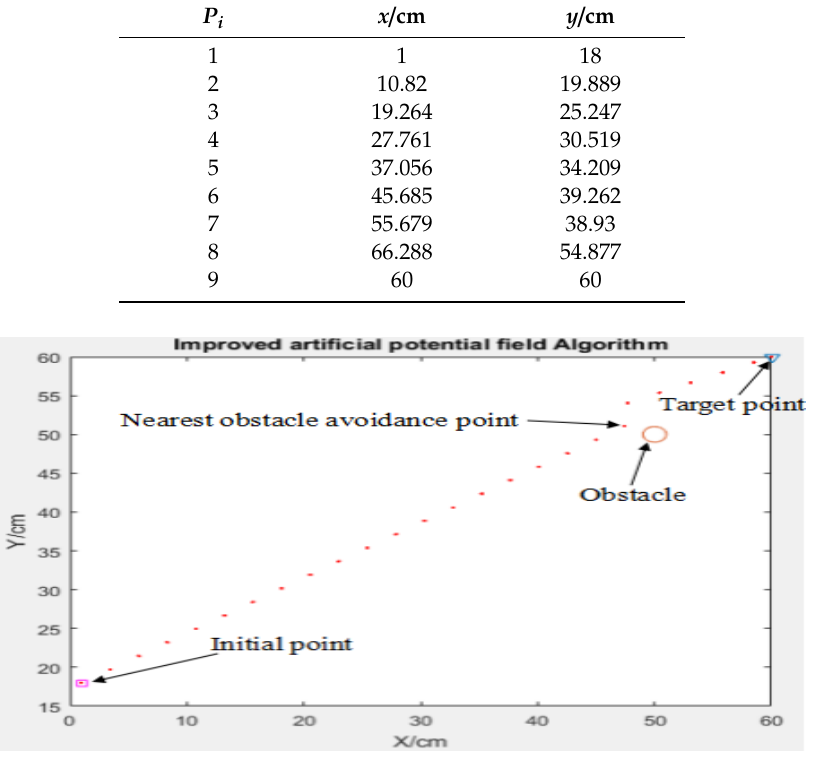
0 Table 5. Joint angles of the pickup manipulator at path points. P i